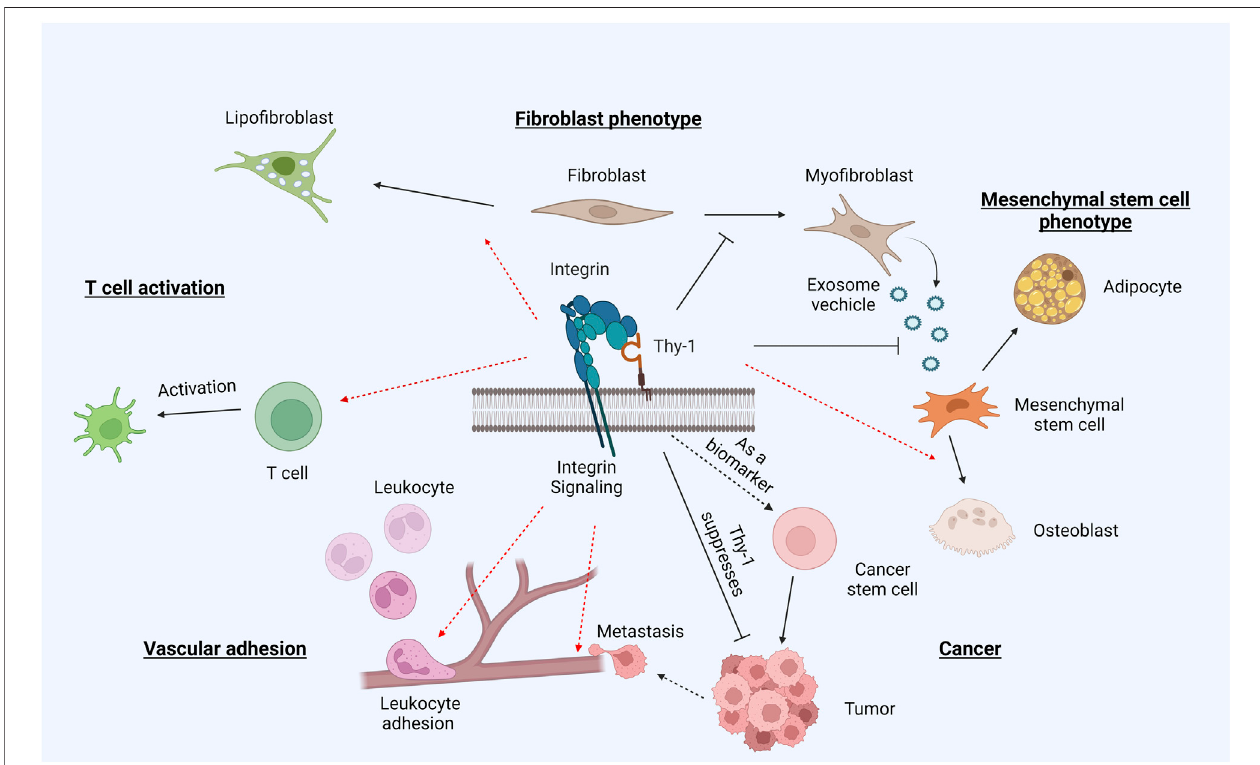
FIGURE 3 | Thy-1 and integrin in pathophysiology. Through binding and regulating integrins, Thy-1 plays an intricate role in differentiation and tumorigenesis. The presence of Thy-1 promotes differentiation of naïve fi broblasts into lipo fi broblasts, but suppresses myo fi broblast activation. Similarly, Thy-1 drives MSC differentiation into osteoblasts, while inhibiting differentiation into adipocytes. The Thy-1 – integrin interaction also promotes T cell activation and leukocyte adhesion. In cancer, Thy-1 displays somewhat contradictory roles – often regarded as an oncogene, but also promoting metastasis through its trans interaction with integrins.